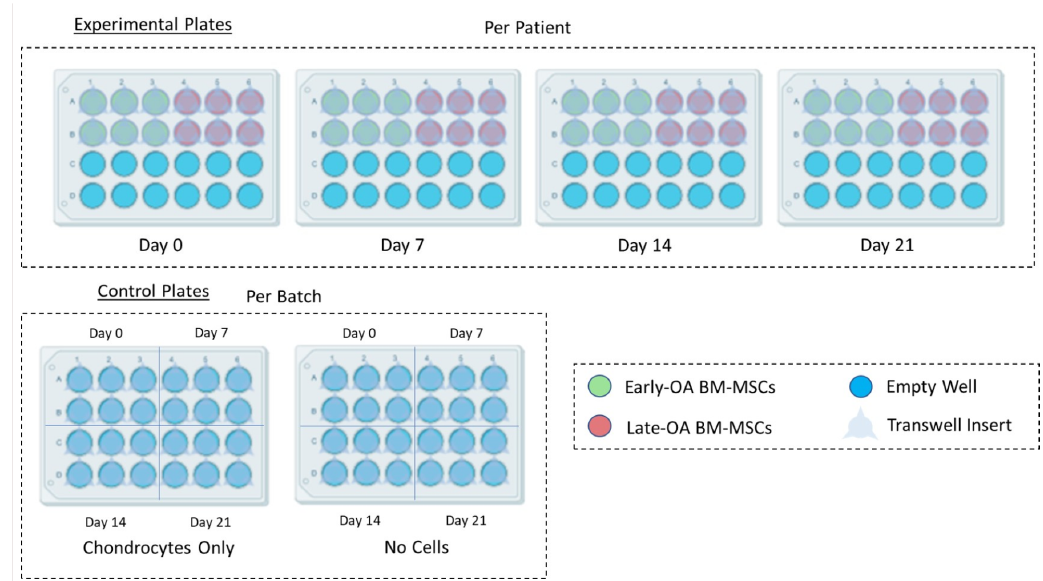
Figure 2. Plate layout for the setup of the co-culture model (created using Biorender.com). For each patient, four experimental plates (day 0, day 7, day 14 and day 21) were seeded with both early OA and late-OA BM-MSCs (6 wells each). BM-MSCs were osteogenically differentiated, and then chondrocyte-seeded agarose scaffolds in transwell inserts were added to the experimental plates and to the chondrocyte-only control plate. Inserts containing agarose alone, with no chondrocytes, were added to the no cells control plate. Experimental plates were set up per patient, whereas the chondrocyte only and no cell control plates were set up per